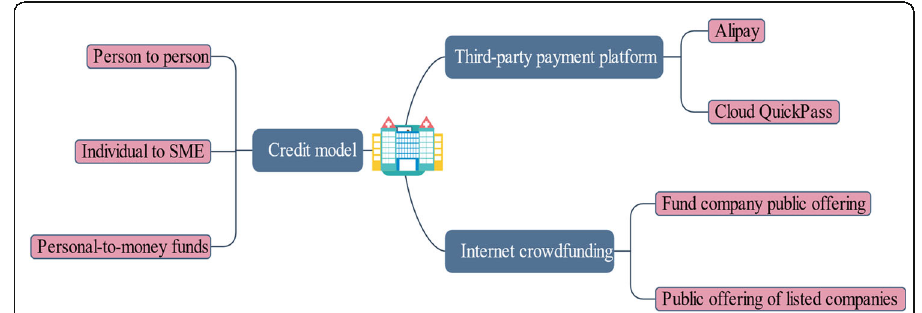
Fig. 1 Structure diagram of the Internet finance development